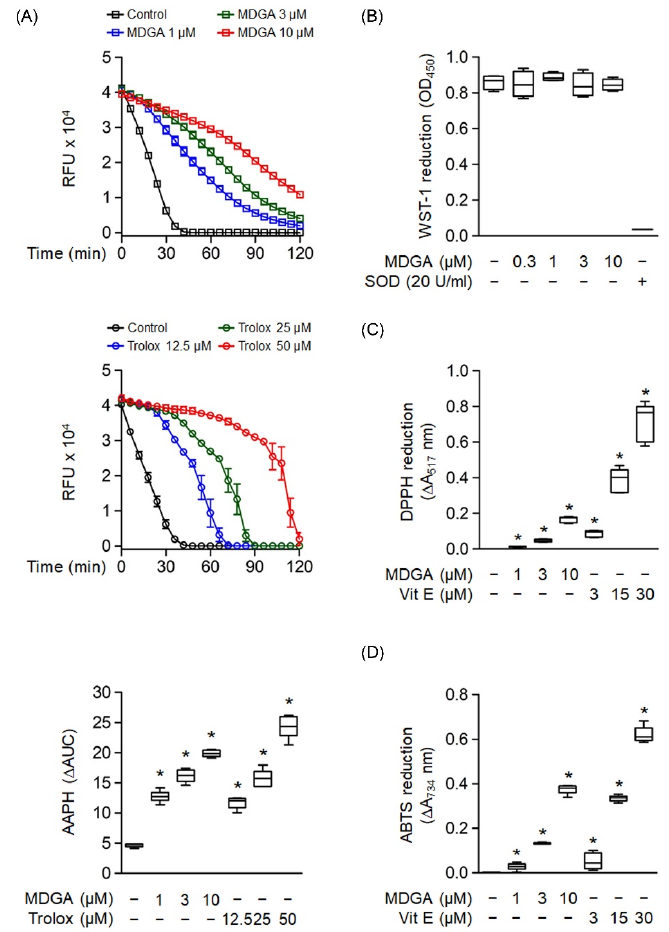
Figure 3. Radical scavenging effects of meso -dihydroguaiaretic acid (MDGA). ( A ) The change in absorbance of fluorescence curves of 2,2 (cid:48) -azobis(2-methylpropionamidine) dihydrochloride (AAPH) represented the decay of MDGA and Trolox ( n = 6). The lower panel demonstrated quantitative fluorescence levels of MDGA and Trolox. ( B ) Reduction in WST-1 by xanthine/xanthine oxidase was measured spectrophotometrically at 450 nm. Superoxide dismutase (SOD) was used as a positive control ( n = 4). ( C ) 1,1-Diphenyl-2-picrylhydrazyl radical (DPPH), was incubated with DMSO (0.1%, as control), MDGA (1, 3, and 10 µ M), or vitamin E (Vit E; 3, 15, and 30 µ M). Reduction in DPPH was calculated spectrophotometrically at 517 nm (n = 6). ( D ) 2,2 (cid:48) -Azino-bis(3-ethylbenzothiazoline- 6-sulfonic acid) diammonium salt (ABTS) was incubated with DMSO (0.1%), MDGA (1, 3, and 10 µ M), or Vit E (3, 15, and 30 µ M). Reduction in ABTS was measured spectrophotometrically at 734 nm ( n = 6). All data are expressed as mean ± S.E.M. * p < 0.05 vs.